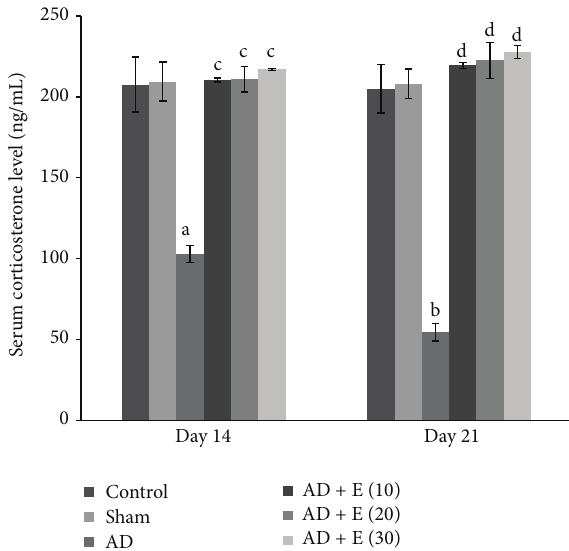
Figure 6: Serum corticosterone level in different experimental groups of rats. a cAD versus control/sham operated rats at day 14 ( 𝑝 < 0.001 ). b cAD versus control/sham operated rats at day 21 ( 𝑝 < 0.001 ). c cAD versus etoricoxib treated cAD at the doses of 10, 20, and 30 mg/kg body weight at day 14 ( 𝑝 < 0.001 ). d cAD versus etoricoxib treated cAD at the doses of 10, 20, and 30 mg/kg body weight at day 21 ( 𝑝 < 0.001 ). Abbreviations are the same as in Figure 1. Values are expressed in mean ± SEM ( 𝑛 = 6 in each